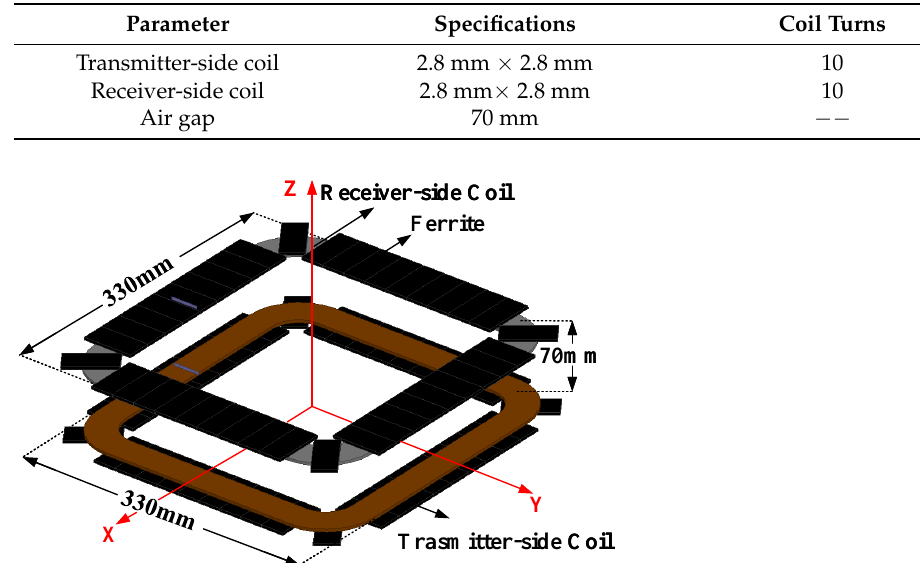
Table 1. The size parameters of the LCT in the CLC/N compensated WPT system.